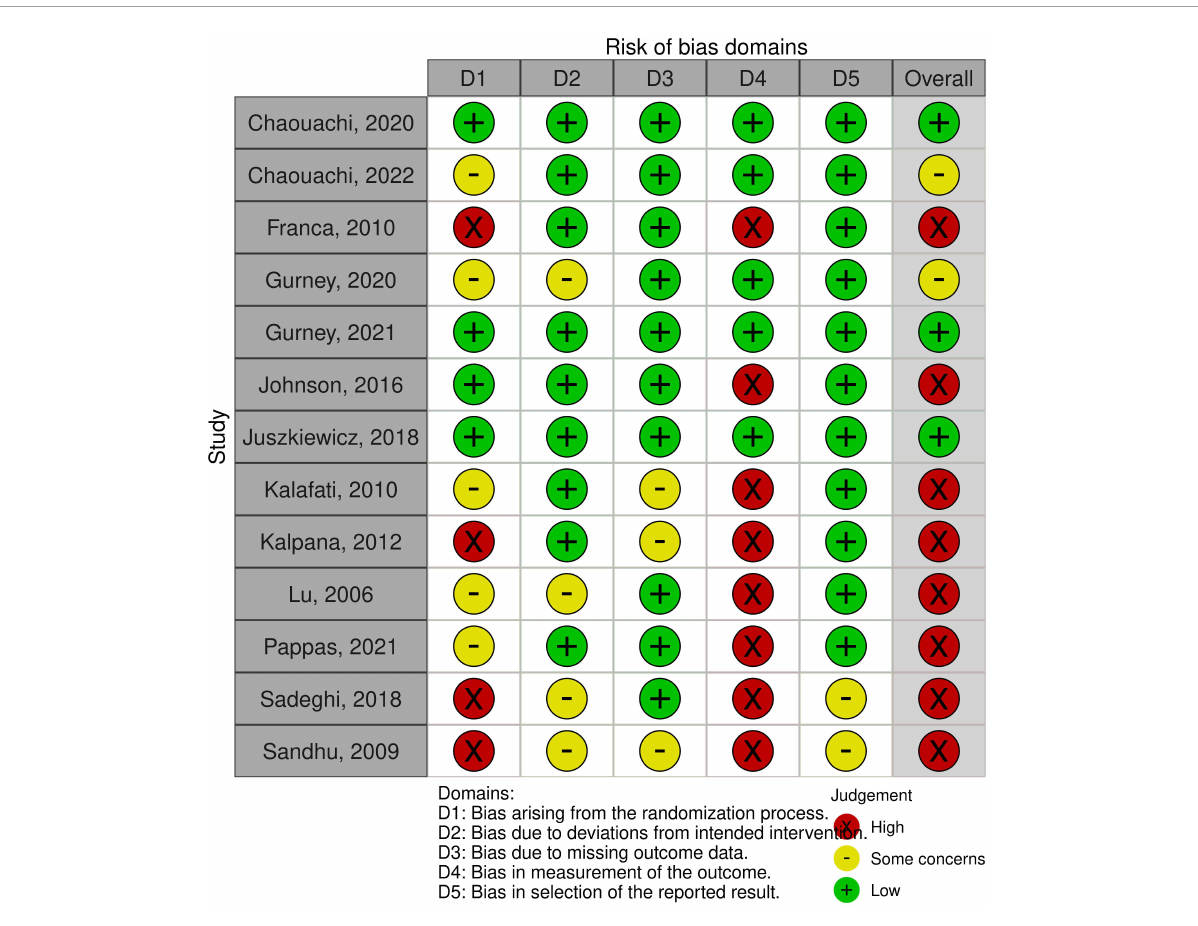
FIGURE2 Methodological quality of the studies using the tool RoB